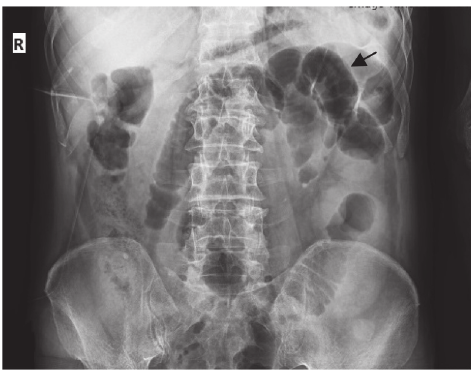
Figure 5: Male patient’s supine abdominal X-ray.